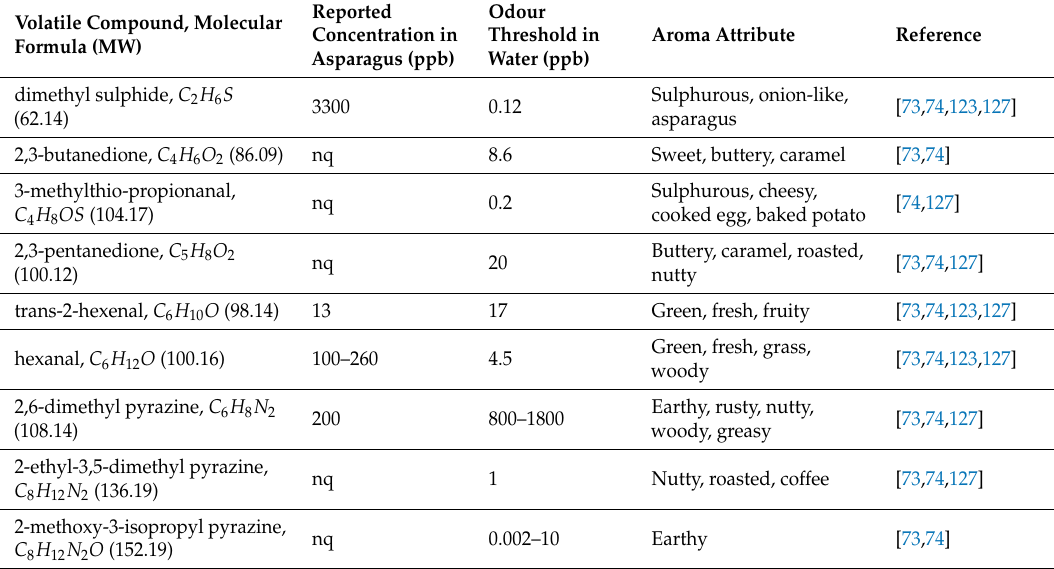
Table 2. Summarized list of the key odorants in cooked asparagus flavour, based on the literature. The concentration in asparagus, odour threshold in water [126] and the characteristic aroma attribute of each volatile are also indicated if known (MW: molecular weight in g/mol, nq: not quantified, nd: not